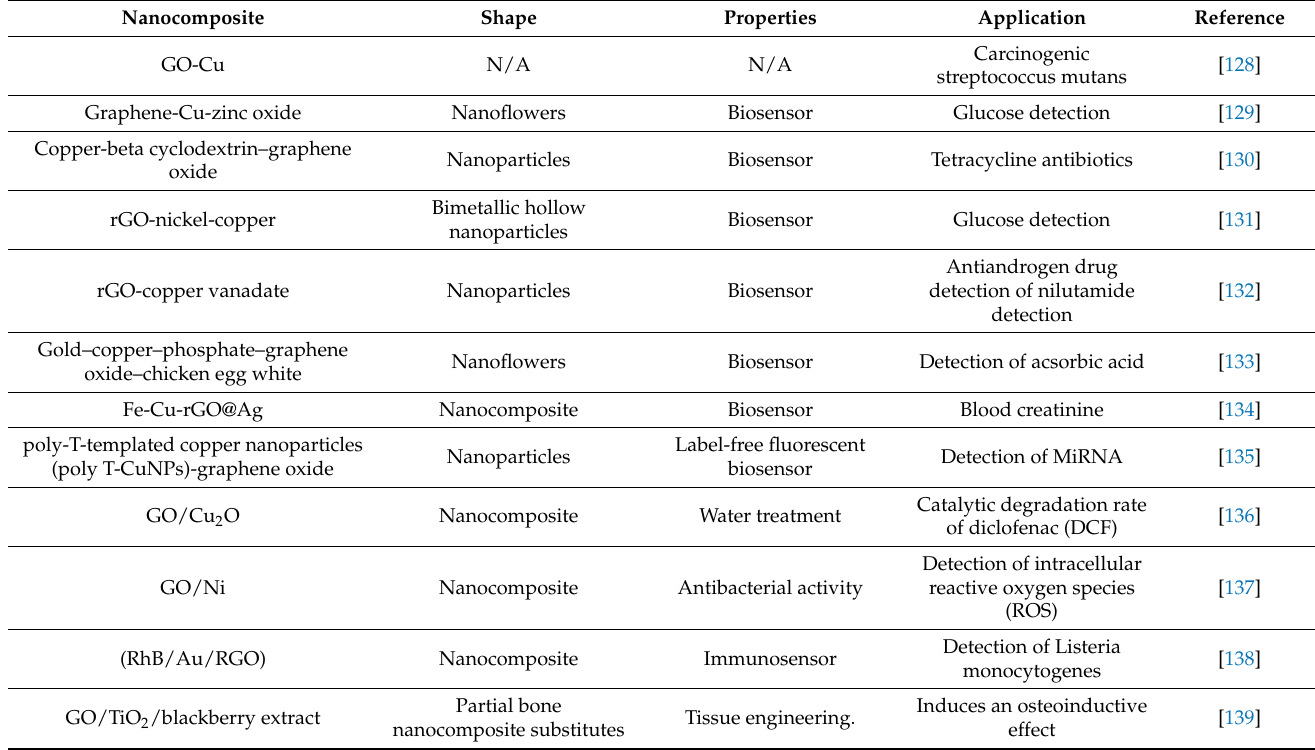
Table 2. Biomedical Applications of Graphene Oxide–Metal